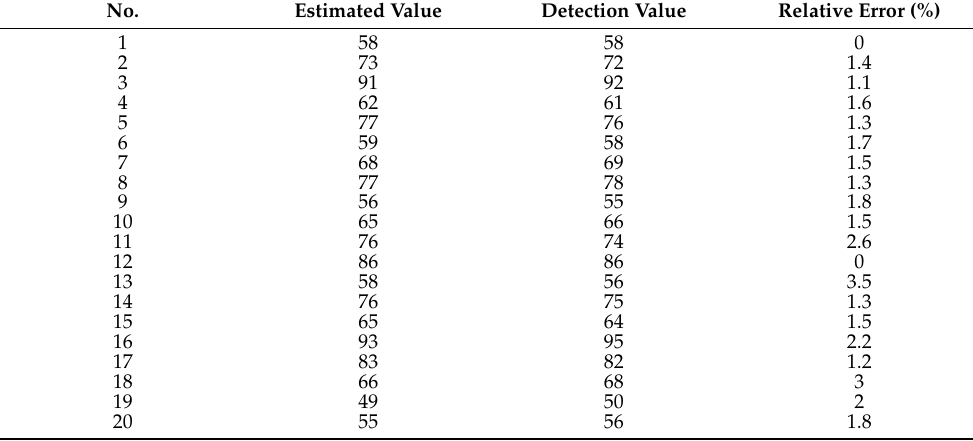
Table 6. Estimated and detected